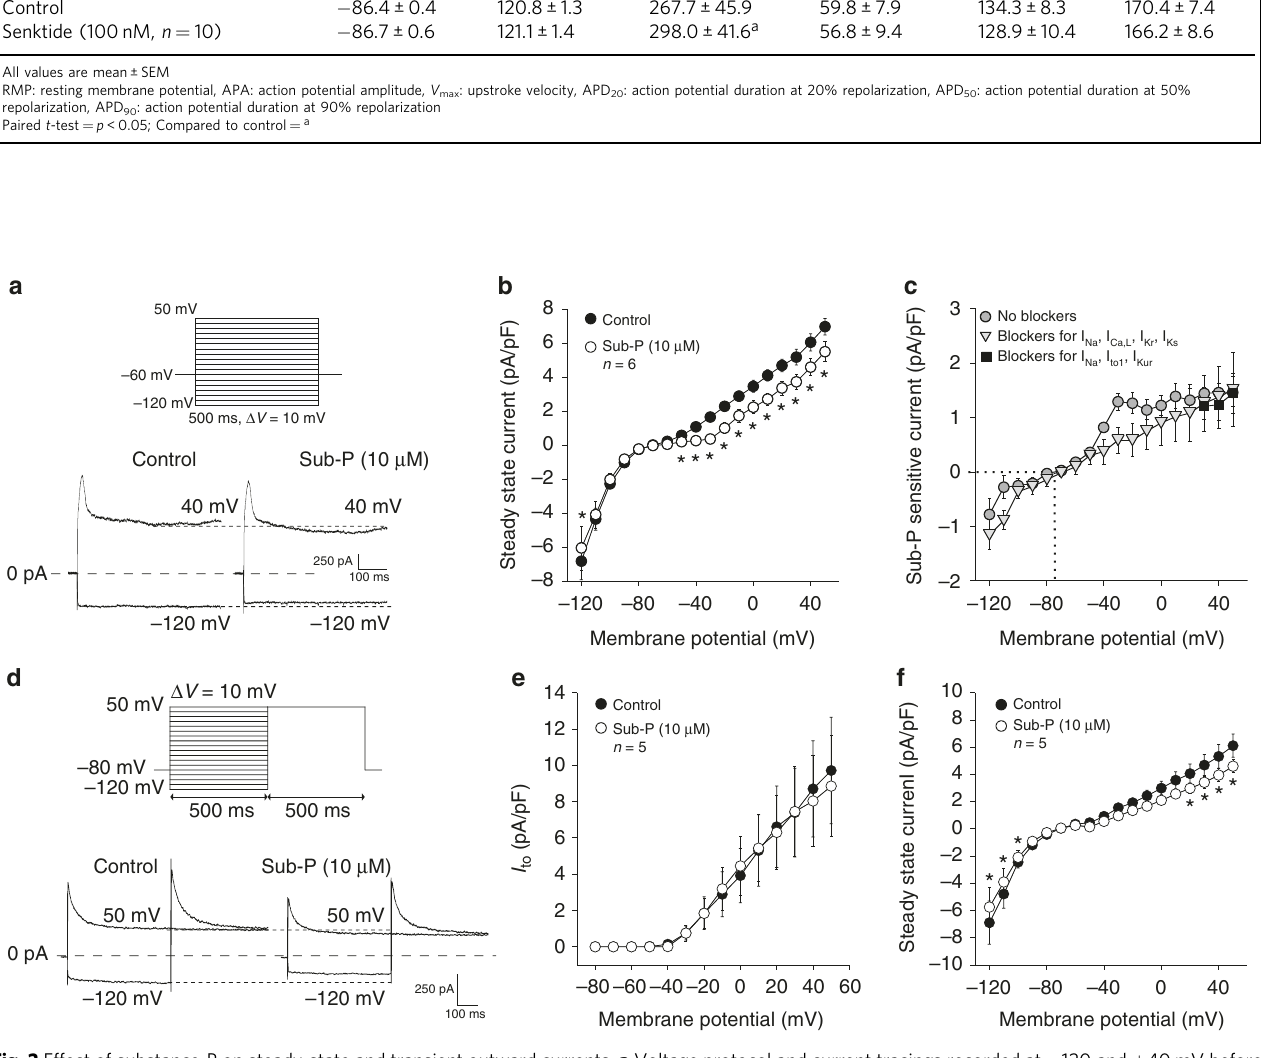
Fig. 2 Effect of substance-P on steady-state and transient outward currents. a Voltage protocol and current tracings recorded at − 120 and + 40 mV before (Control) and after application of 10 µ M Sub-P. b Average current – voltage relationships of the steady-state current in Control and after application of Sub-P (10 µ M) ( N = 2, n = 6, two-way RM ANOVA). c Average current – voltage relationships of the Sub-P sensitive current. Sub-P sensitive currents were derived from b (grey fi lled circles), f (grey fi lled triangles) and Supplementary Figure 2 (black fi lled squares), as differential current. d Voltage protocol and transient outward K + current (I to ) current tracings recorded at − 120 and + 50 mV before (Control) and after application of Sub-P (10 µ M). e Average current – voltage (I – V) relationships of I to peak currents before (Control) and after application of Sub-P (10 µ M) ( N = 4, n = 5, two-way RM ANOVA). f Average I – V relationships of steady-state current before (Control) and after application of Sub-P (10 µ M) ( N = 4, n = 5, two-way RM ANOVA). Blockers for Na + , L-type Ca 2 + , rapid and slow delayed recti fi er K + currents were present. All values shown are mean ± SEM. * P <